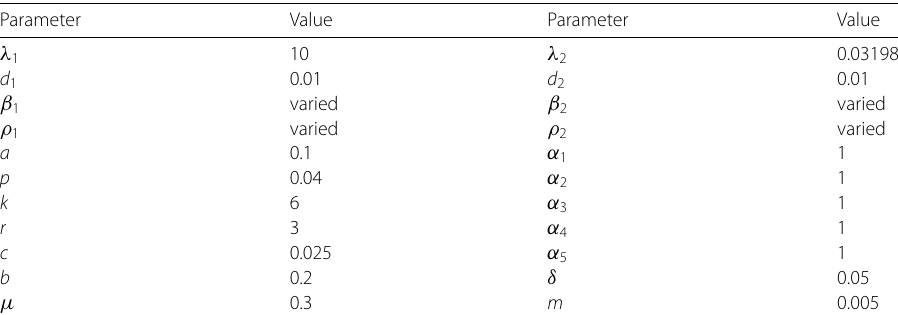
Table 1 The parameter values of model (6)–(13) Parameter Value